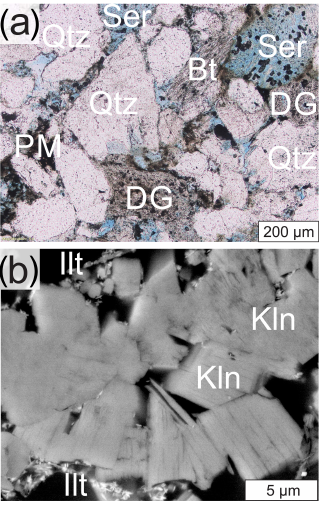
Figure 6. (a) Representative thin section taken from rock cube OSB2_c. The sandstone consists mainly of quartz (Qtz), altered feldspars with residual mineral aggregations (sericite – Ser), altered biotite (Bt) and ductile grains (DG). Feldspar dissolution lead to a high grade of secondary porosity (Molenaar et al., 2015), while the vast majority of the intergranular pore space is filled with pri- mary and pseudomatrix (PM) which is rich in iron oxides. (b) Envi- ronmental scanning electron microscope (ESEM) image of the au- thigenic clay minerals, mainly kaolinite (Kln) and illite (Ilt), built in the pore space. Mineral abbreviations were taken from Whitney (2010).